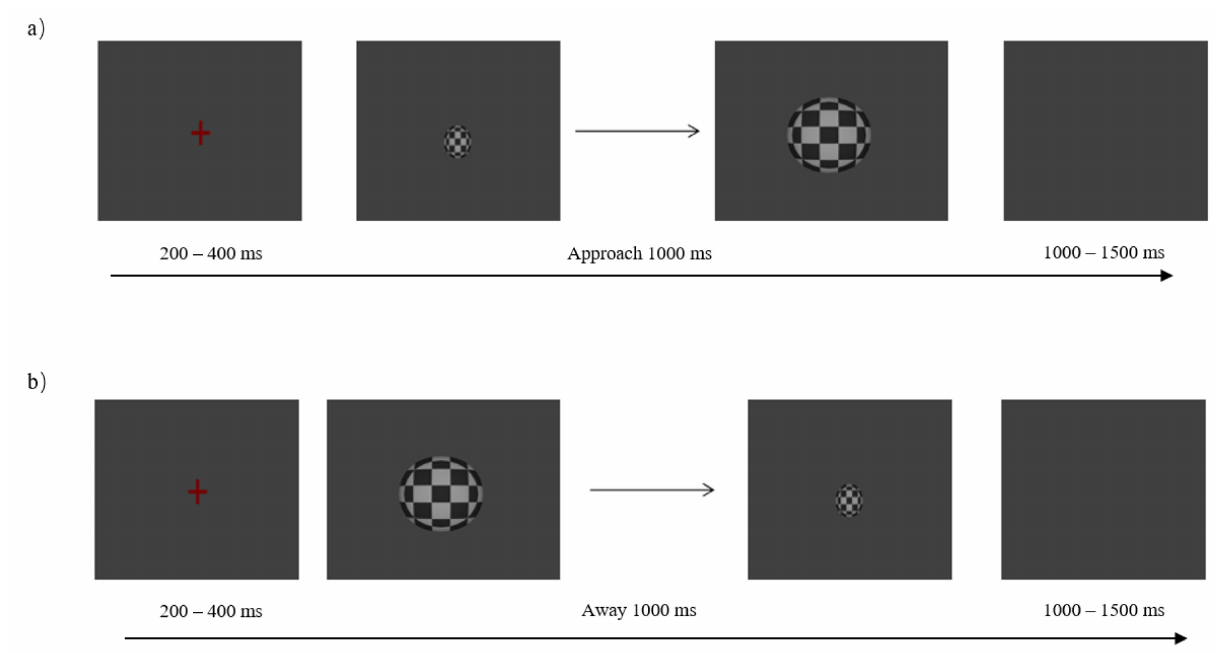
Figure 1. Schematic diagram of the experimental procedure of the deep motion approaching ( a ) and away ( b ) processes. When the sphere appeared, participants were required to press “J” or “F” as soon as